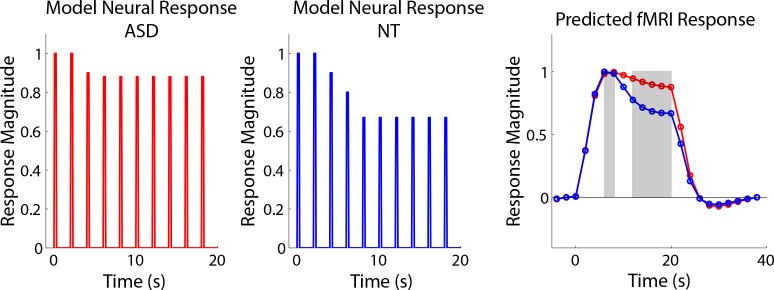
Model neural responses that reflected different degrees of adaptation (left = ASD, less adaptation; middle = NT, more adaptation) were convolved with a canonical hrf to produce expected fMRI timecourses for each group (right).